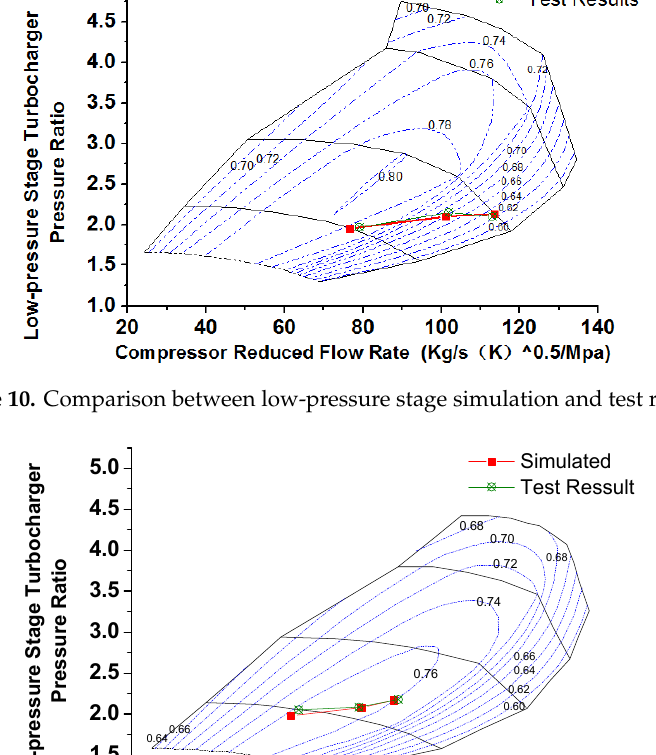
computer S 2 Figure 9. Schematic diagram of the test platform and test equipment. Note: P—pressure sensor, T— temperature sensor, M—intake flow sensor, S1—synchronization signal, S2—photoelectric encoder, O 2 —oxygen sensor. Figures 10–12 show the comparison between the experimental data and simulation results of the